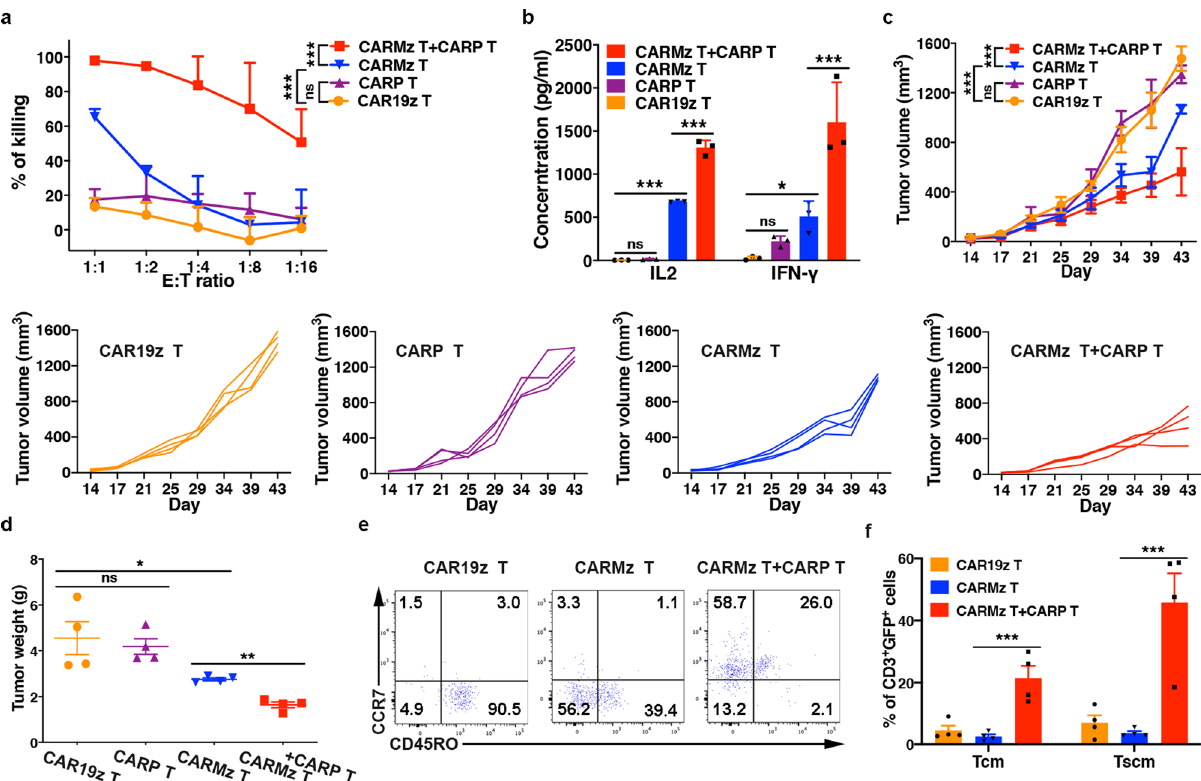
Fig.1|CARPTcellsenhancetheantitumoref fi cacyofCARMzTcells.a CARPT, CARMz T, a mixture of CARMz T and CARP T and control CAR19z T cells cyto- toxicity against HeLa-GL cells were measured at various E:T ratios. Data are pre- sentedasmean±SD( N =3independentexperiments). p Values(CAR19zTvs.CARP T=0.115, CAR19z T vs. CARMz T=2.903E − 04, CARMz T+CARP T vs. CARMz